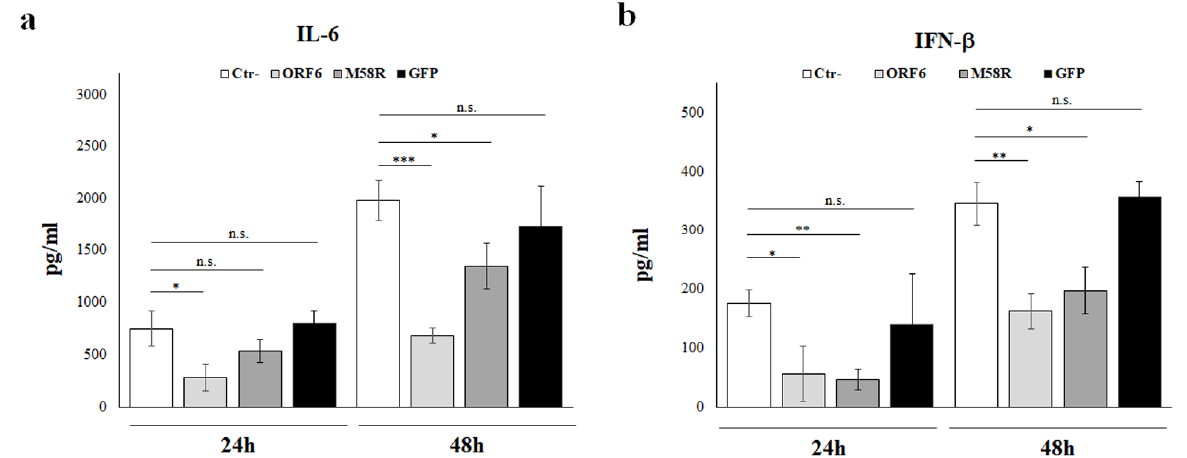
Figure 5. ORF6 protein hinders IL-6 secretion and IFN-β. The production of IL-6 ( a ) and IFN-β ( b ) by A549 cells was tested at early (24 h) and late (48 h) post ORF6, M58R or GFP expression by enzyme-linked immunoassay (ELISA). Negative control (Ctr-) was represented by A549 cells transfected with empty plasmid alone. Quantitative evaluation was performed based on relative standard curves and results are reported as mean concentration (pg/mL) ± standard deviations from three separate experiments ( n = 3). Significance was evaluated as p < 0.05 (*** p < 0.0005, ** p < 0.005, * p < 0.05, n.s. not significant).